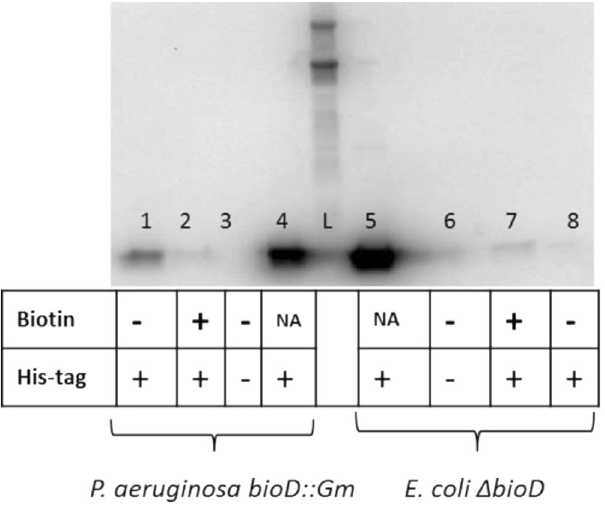
Figure 7. Western blot analyses of freestanding and operon-encoded BioH production. Equal volumes of the freestanding and operon-encoded protein eluates were loaded into each lane of an SDS-polyacrylamide gel. After electrophoresis the proteins were transferred to Immobilon-P and the membranes were subjected to immunoblotting with anti-His 6 tag antibody. Lane 1, the P. aeruginosa bioD::Gm strain expressing chromosomal His tag under limited biotin conditions (1.6 nM); Lane 4, positive control, purified P. aeruginosa BioH protein with a C-terminal His